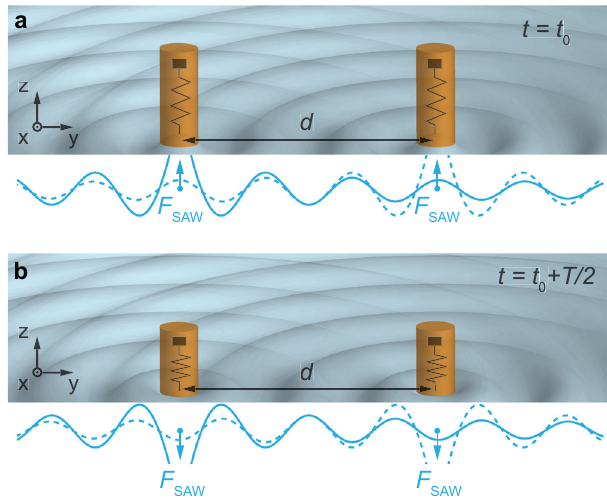
is usually represented by a spring connecting two spring-mass systems 9,21 . In doing so, the interaction between the resonators is assumed to be instantaneous. This assumption is not valid if the resonators interact with SAWs. In this case, the coupling between the resonators has a delay. This is the propagation time of a SAW, which is created by one resonator 22,23 and travels to the other. Delay-coupled systems have been studied before: two resonators mounted on a string 24 , two resonators coupled by a rod 25 , or the interaction of air bubbles in water 26 – 29 , for example. However, a radiative coupling by SAWs between three-dimensional micro- or